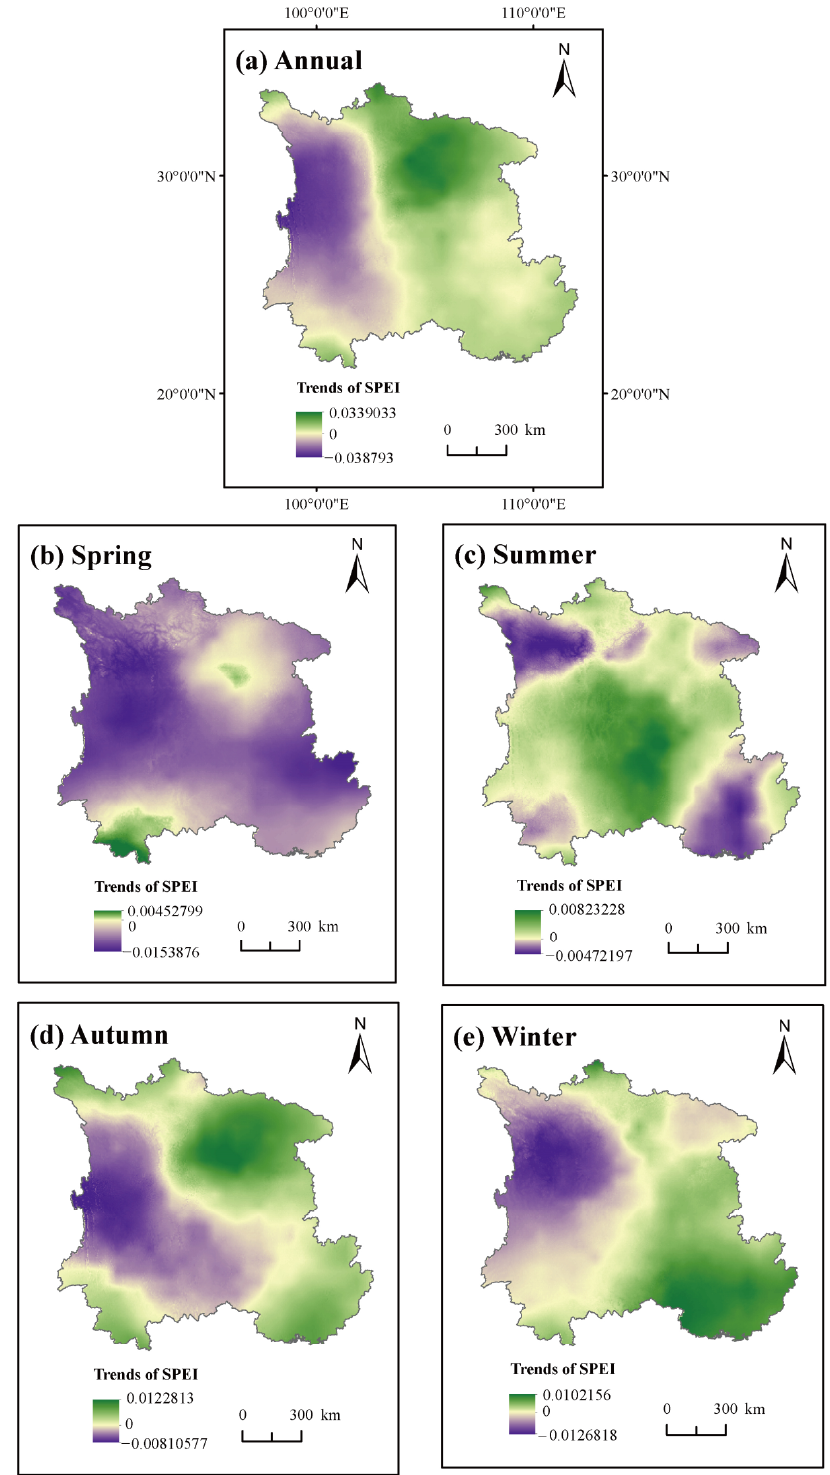
Figure 13. Spatial change trends in mean SPEI from 1990 to 2018. ( a ) Annual; ( b ) spring; ( c ) summer; ( d ) autumn; ( e ) winter.